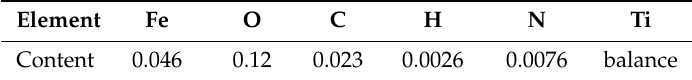
Table 1. Chemical composition of feedstock, wt. %.